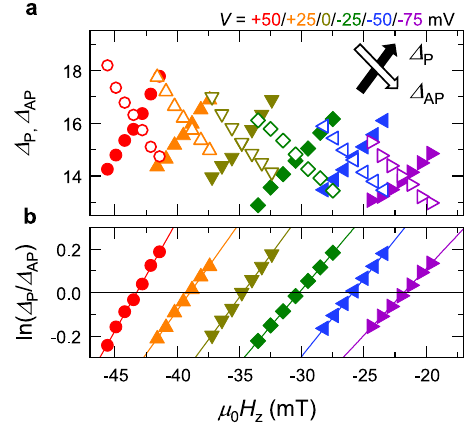
Fig. 5 Δ P , Δ AP , and their ratio. a Thermal stability factors for P and AP states Δ P and Δ AP are determined by RTN measurement. b Natural log of their ratio as functions of perpendicular magnetic fi eld H z and